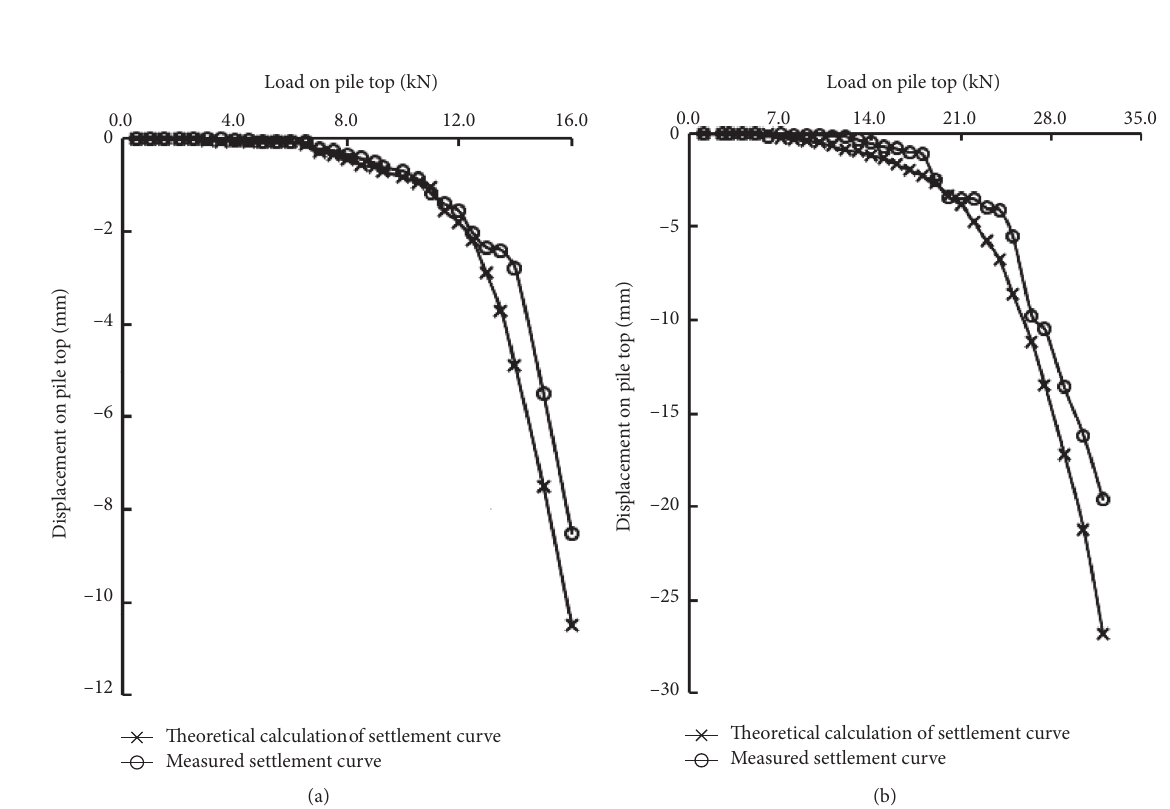
Figure 5: Comparison of the measured and the theoretically calculated settlement curves: (a) four piles; (b) eight piles.